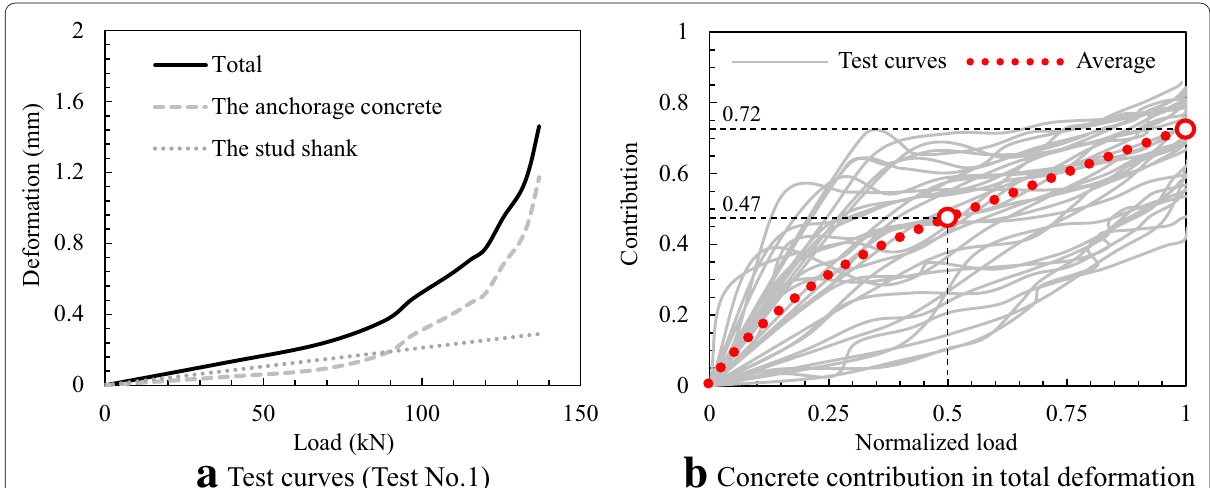
Fig. 7 Contribution of the anchorage concrete to the tensile deformation of headed studs.